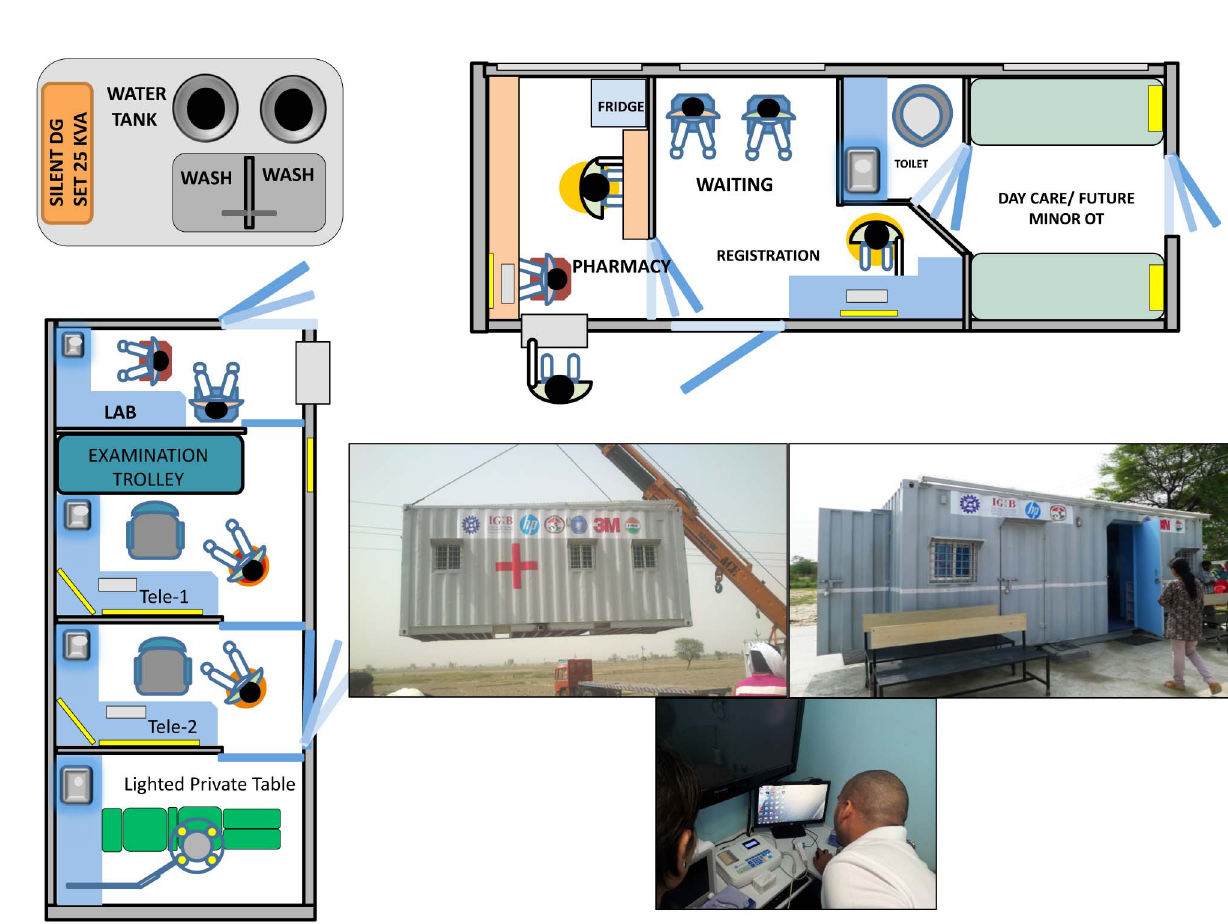
Figure 1. Layout of the eHC. Two 20 6 8 feet containers were used in the proof-of-concept eHC. The telemedicine container (left) has provision for a small laboratory. The second container (top) is used for registration and pharmacy and also has space for a future minor operation theatre. The telemedicine container can be used by itself for basic eHC operations. Pictures of the deployment, exterior, and interior of the telemedicine container are shown.